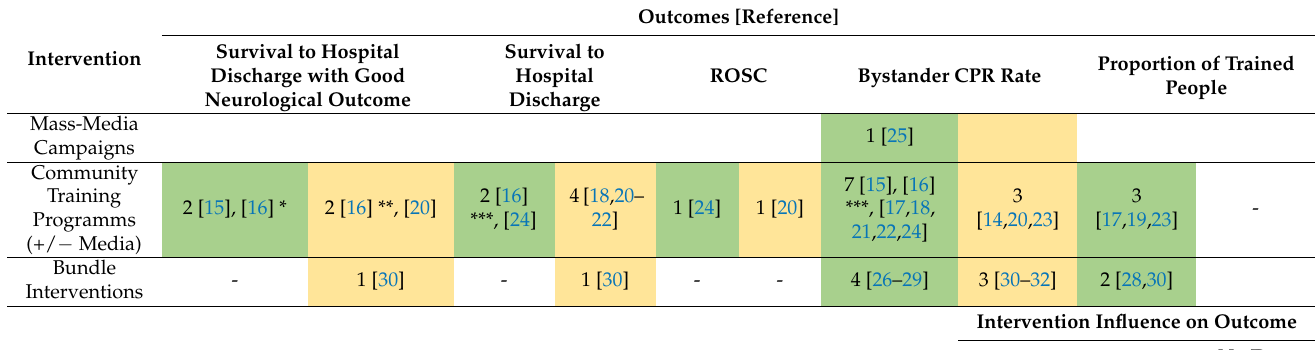
Table 2. The impact of each intervention on the assessed